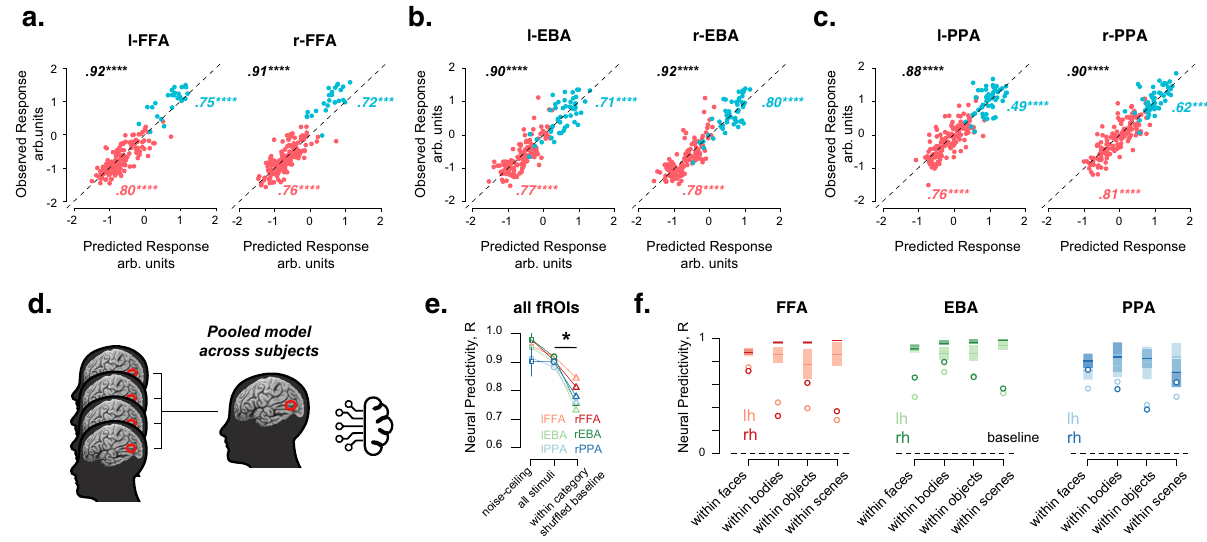
Fig. 2 Models accurately predict image-level responses of the FFA, PPA, and EBA and generalize across subjects. a Scatterplots show the cross- validated predicted response ( x -axis) v/s observed response ( y -axis) for each of the 185 stimuli for the left and right FFA (left and right columns, respectively). Numbers indicate correlation between the predicted and observed data across all stimuli (black text), for stimuli within the hypothesized preferred category (blue dots and text) and stimuli not within the hypothesized preferred category (pink dots and text). The dotted line denotes the x = y line and **** is P < 0.00005. Source data are provided as a Source Data fi le. b Same as a but for left and right EBA. Source data are provided as a Source Data fi le. c Same as a but for left and right PPA. Source data are provided as a Source Data fi le. d Schematic describing how the data were pooled across subjects. Data were averaged within each fROI (schematized as a red circle) in every subject and pooled across subjects and the computational models were built to predict the pooled responses for previously unseen images across participants. e Computational models predict the responses to individual stimuli within each of the fROIs (circles) signi fi cantly better than the within-category image shuf fl ed baseline controls (triangles). Ticks indicate the mean and the errorbars indicate the std over samples. N = 6 fROIs. * is P = 0.03, two-sided Wilcoxon signed-rank test across fROIs, demonstrating predictive accuracy as a function of not just category but individual images. Source data are provided as a Source Data fi le. f Computational models predict responses to individual stimuli even for stimuli within each of the categories. Each circle indicates the model performance for the FFA (left column), EBA (middle column), and the PPA (right column), the dashed line at 0 indicates the expected baseline performance if models did not predict any image-grained variance within the categories. The shaded regions indicate the estimated noise-ceiling of the data. Source data are provided as a Source Data fi